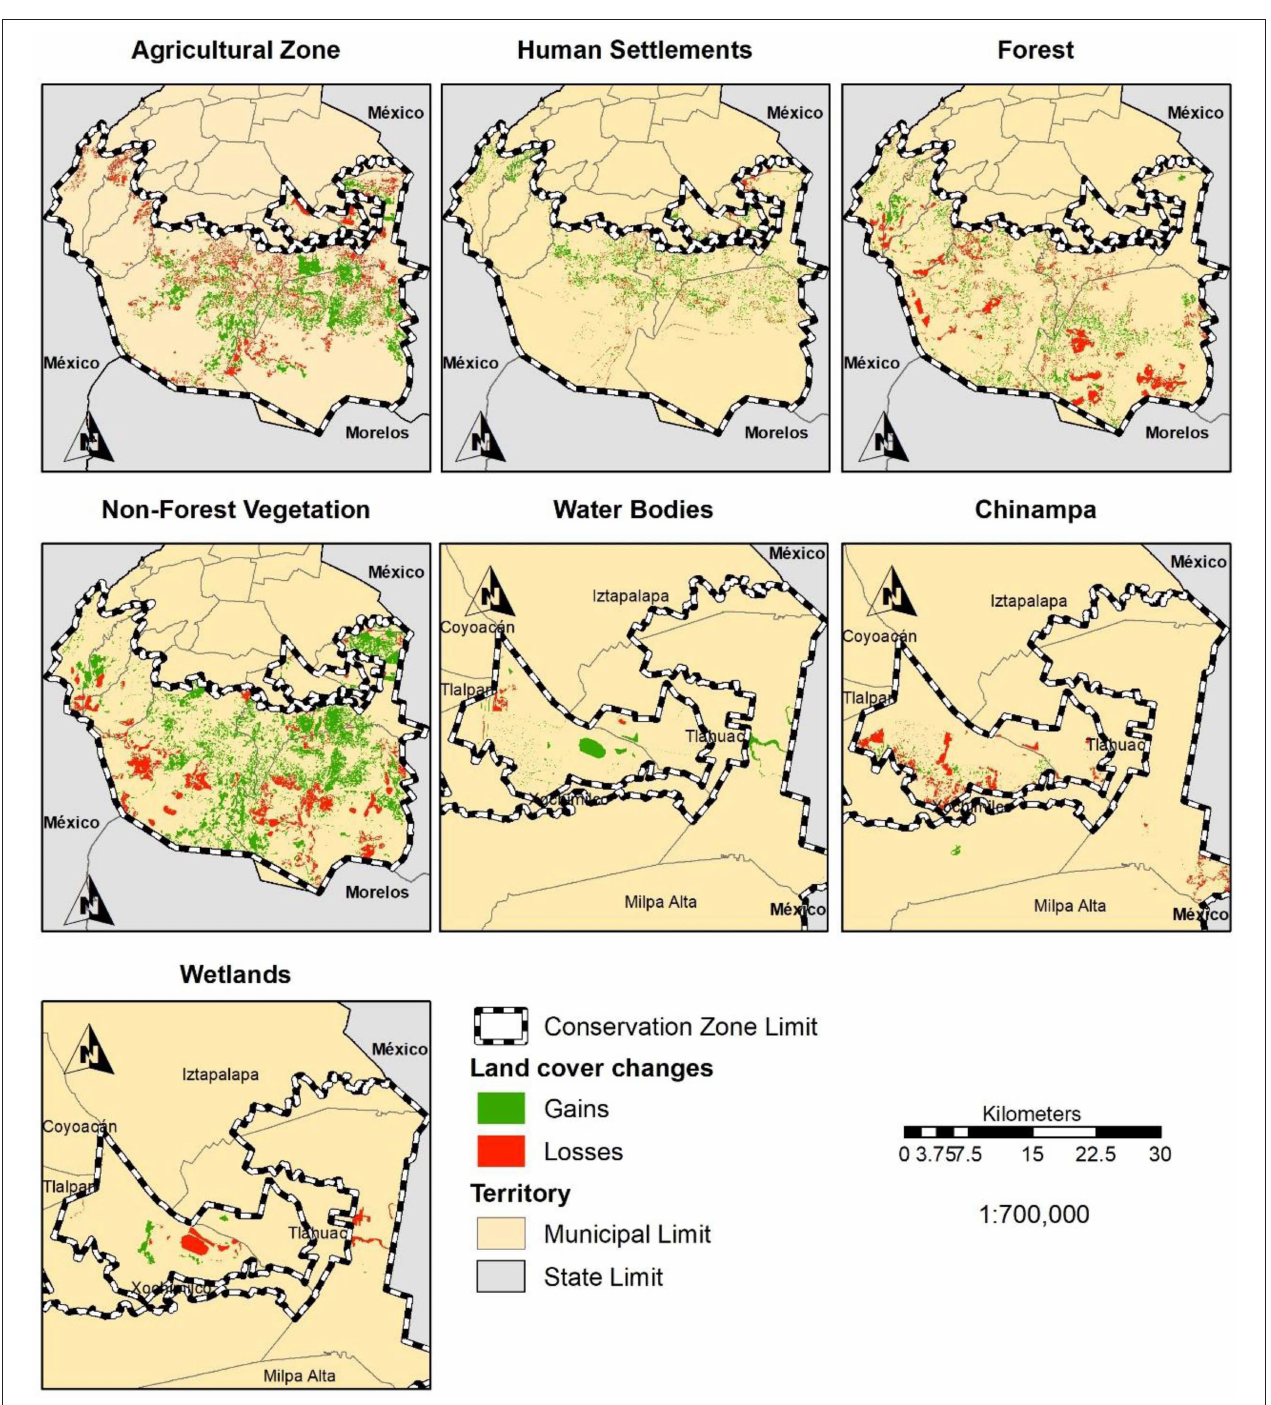
FIGURE 7 | The conservation zone: sequence of maps of land use gains and losses by category, 2010–2020. Elaborated from land use and vegetation layers of Serie II from INEG I (National Institute of Statistics and Geography, 2001); GDF (2012) Atlas Geografico del Sue lo de ConservaciÒn del Distrito Federal; and Esri Land Cover,